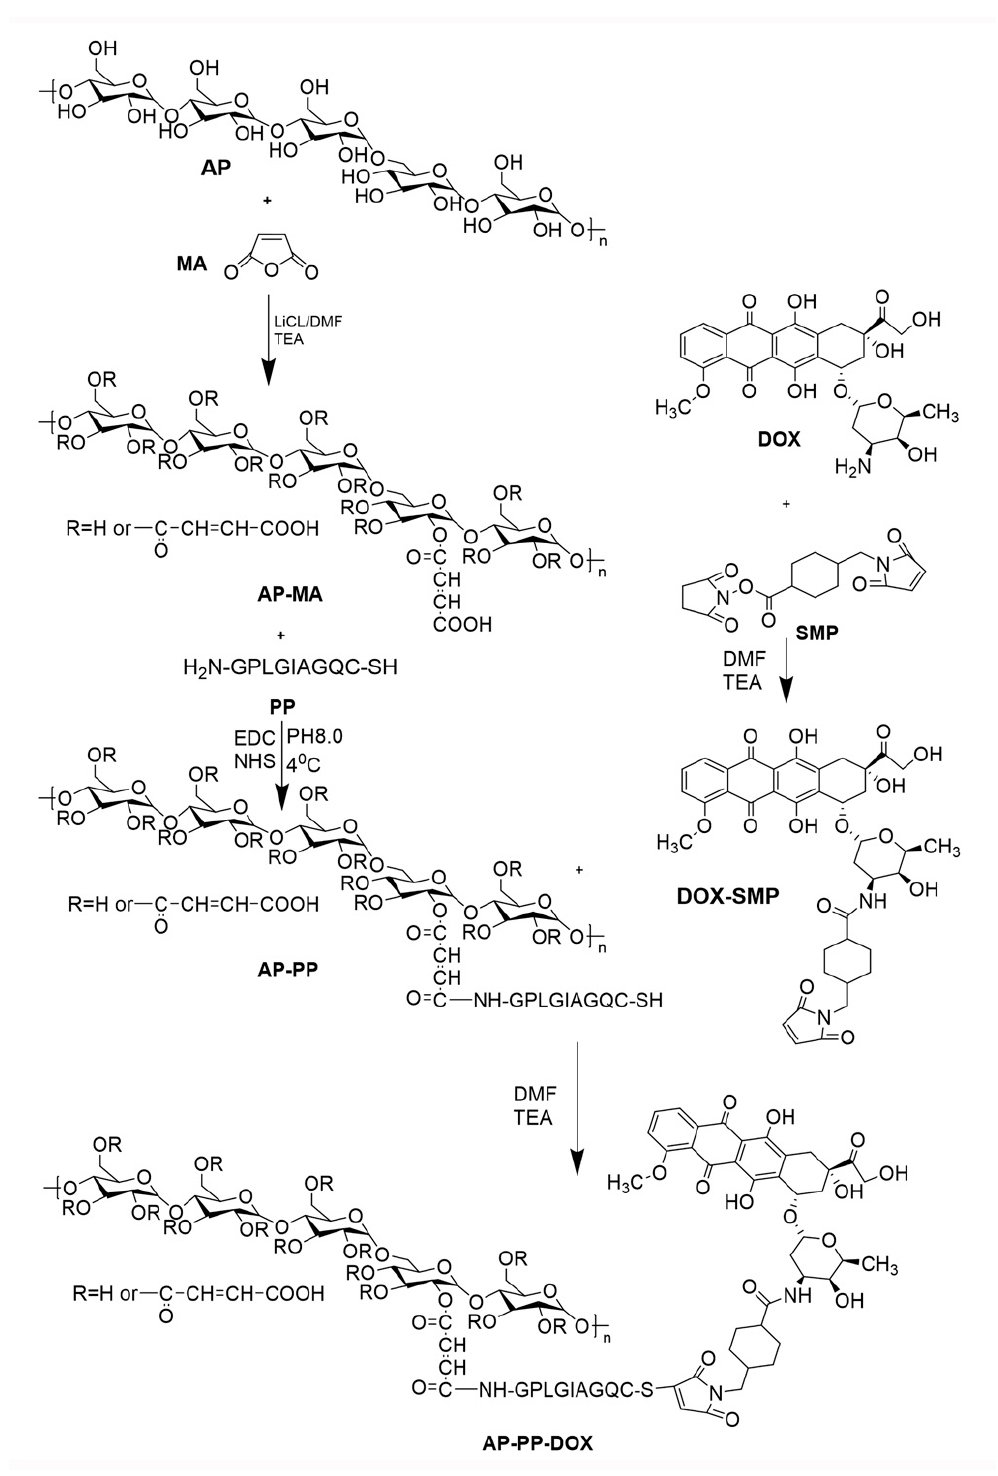
Figure 2. Synthetic scheme of AP-PP-DOX conjugates.